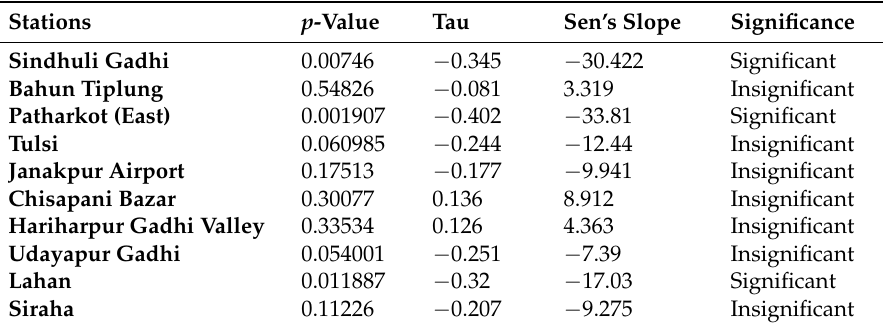
Table 7. Monsoon Rainfall trend.